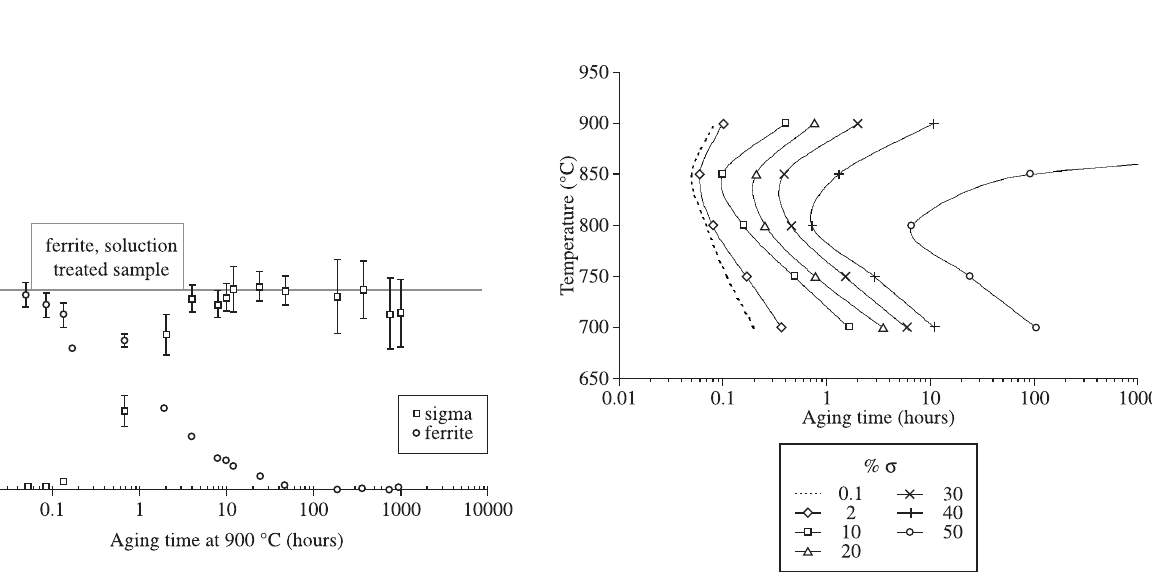
Figure 9. Equilibrium volume fraction of phases thermodynamically calculated.